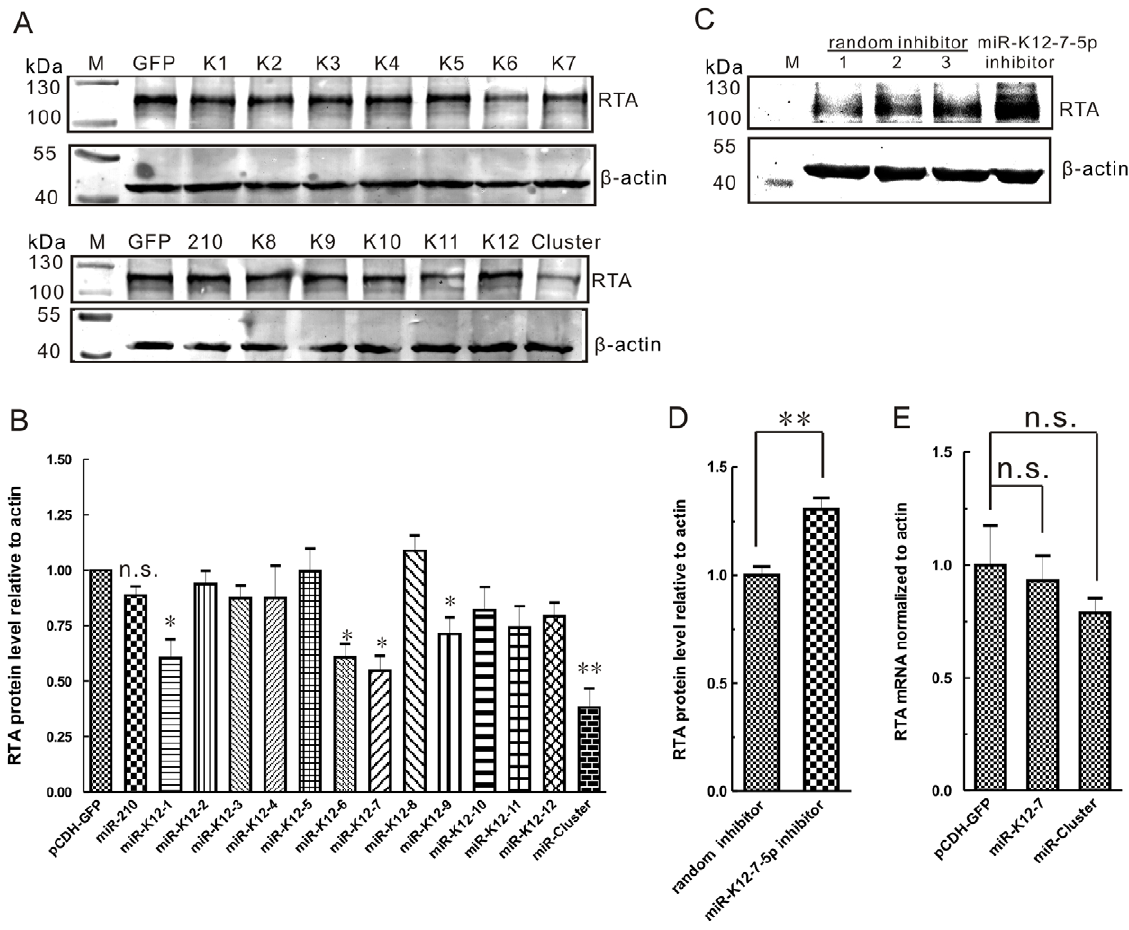
Figure 3. miR-K12-7 inhibits RTA expression at the protein level but not at the mRNA level. (A) The transient expression of miR-K12-7 repressed RTA protein expression in the latently KSHV-infected 293/Bac36 cell line. Latently KSHV-infected 293/Bac36 cells were synchronized by culture in serum-free medium and pretransfected with 4 m g of individual miRNA-expressing constructs or the corresponding empty vector 12 h after the addition of serum. After a further 4 h, the S-phase 293/Bac36 cells were induced to lytic replication with both TPA (25 ng/mL) and VPA (3 mM). Cell lysates were prepared 26 h after induction and were probed for endogenous RTA or b -actin. (B) A graph of RTA levels normalized to those of b - actin of three independent experiments performed in Figure 3A (analyzed with NIH ImageJ). (C) miR-K12-7-5p inhibitor increases RTA expression. Synchronized 293/Bac36 cells were transfected with 200 nM miR-K12-7-5 inhibitor or random inhibitor and were introduced into lytic replication with both TPA (25 ng/mL) and VPA (3 mM). Cell lysates were prepared 48 h after induction and were probed for endogenous RTA or b -actin. (D) A graph of RTA levels normalized to those of b -actin of three independent experiments performed in Figure 3C (analyzed with NIH ImageJ). (E) RTA mRNA levels were not affected by miR-K12-7. At 26 h after induction with TPA and VPA, the 293/Bac36 cells transfected with individual miRNA expression constructs or the corresponding empty vector were harvested and RNAs were extracted from those cells with TRIzol Reagent. RTA mRNA from those cells was assayed by RT–PCR and quantified relative to b -actin mRNA levels. The data shown are from triplicate independent experiments. * P , 0.05; ** P , 0.01; n.s., not significant. t test.